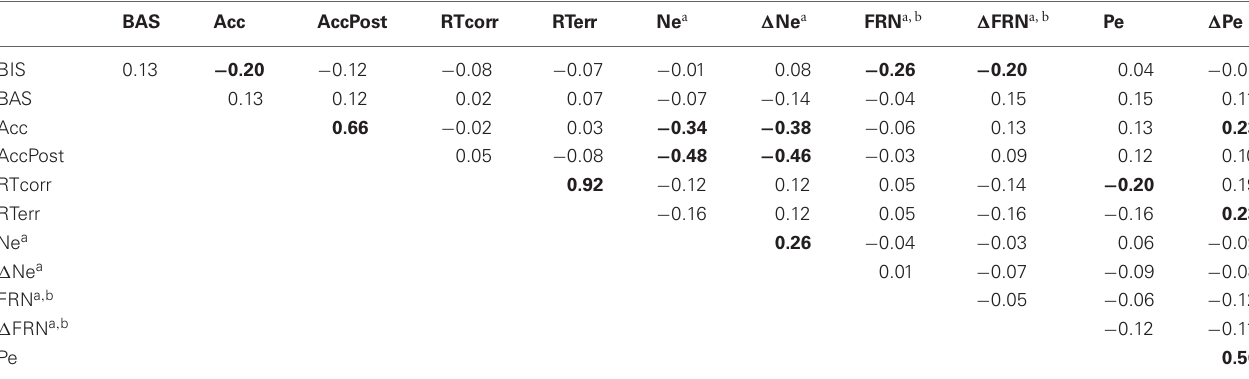
Table 3 | Pearson’s correlations between personality measures, behavioral measures, and ERP components in the probabilistic learning